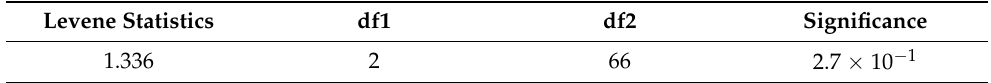
Table 2. Homogeneity test of variance.